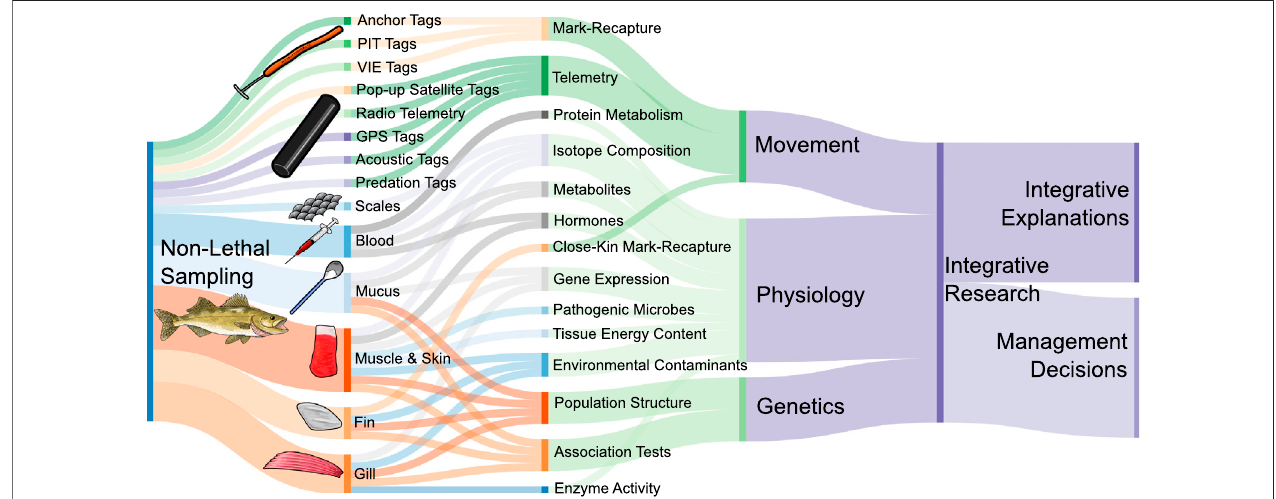
FIGURE1| Conceptualdiagramofdifferenttagging andtissue samplingmethods usedfornon-lethalsamplingandmovementstudies in fi shes. Speci fi csampling and tagging methods are linked to overall approaches in research, although for simplicity, only approaches presented in this review with examples are shown here. The differentresearchapproachesarecategorizedintomovement,physiology,and genetics, whichcan beincorporatedinto integrative researchprojects. Theseintegrative projects are useful for making informed management decisions and fi nding integrative explanations of natural phenomena. Therefore, movement, physiology, and genetics can all inform integrative explanations and management decisions via integrative research. Colour choices are arbitrary, and only for distinguishing elements of the diagram. Created with SankeyMATIC.